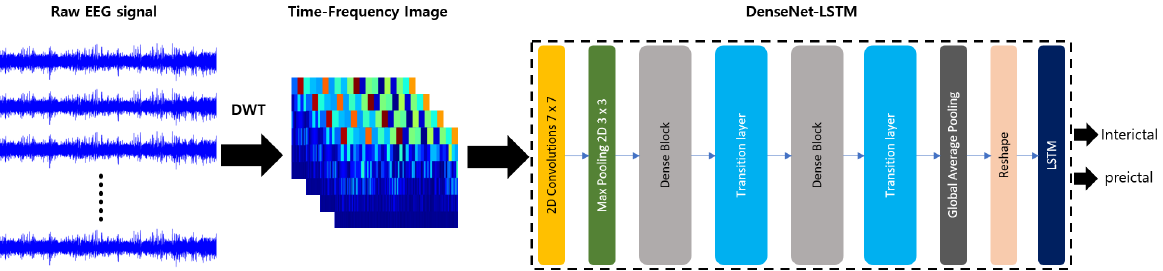
Figure 2. The system model of proposed